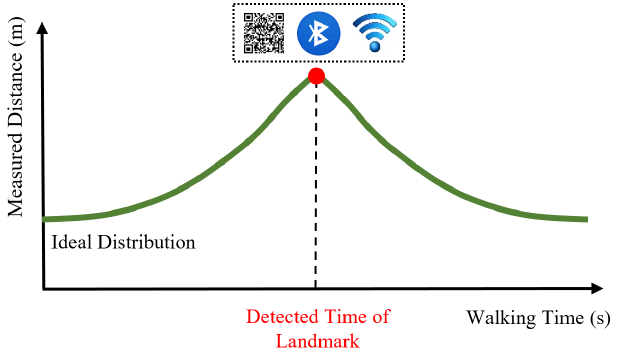
Figure 3. Description of Wi-Fi/BLE/QR landmark detection.